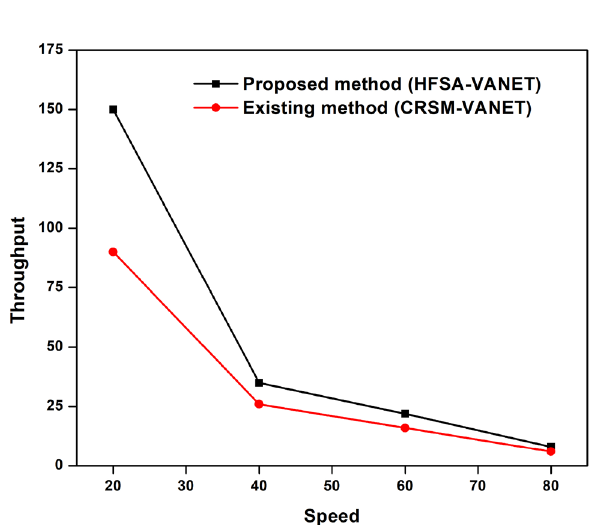
Figure 11. Speed vs throughput plot for a proposed and existing